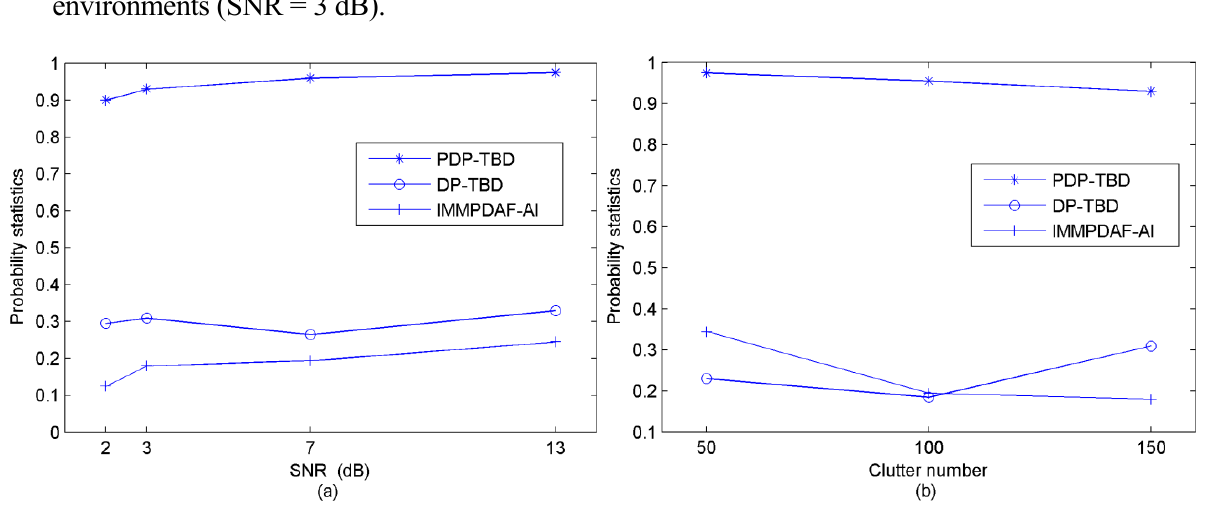
Figure 8. Comparison of the probabilities of correct target number estimation (200 runs, Scenario-2) ( a ) In different SNR environments ( λ = 150); ( b ) In different clutter number environments (SNR = 3